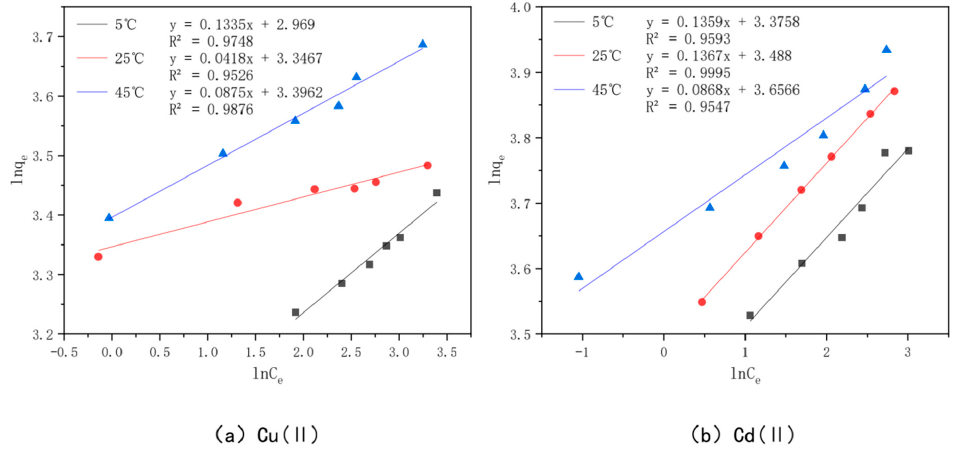
Figure 16. Freundlich models of KAM500-400-3 adsorbing Cu(II)/Cd(II) at different temperatures. Table 7. Fitted data from the KAM500-400-3 isotherm model adsorbing Cu(II) and